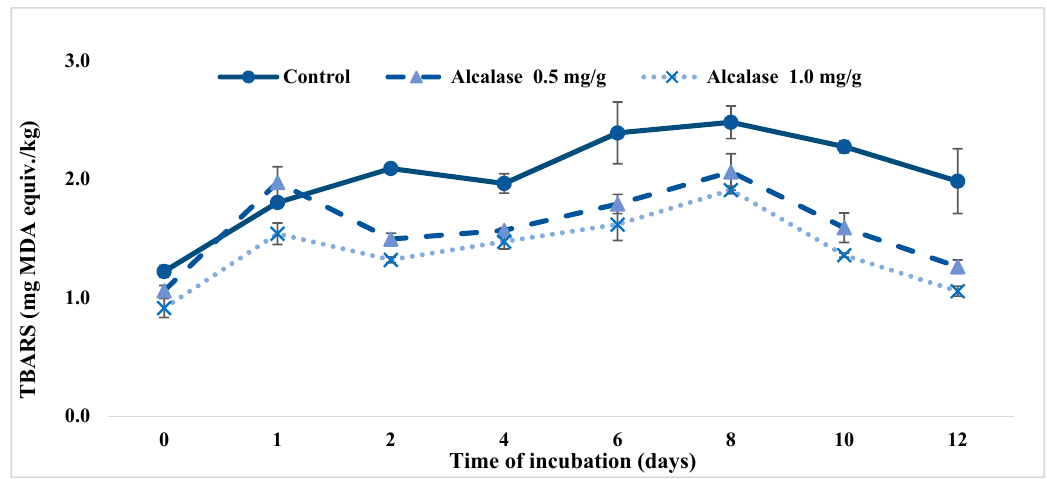
Figure 4 . Inhibition effects of kafirin Alcalase 5–10 kDa hydrolysates, measured as TBARS (mg Figure 4. Inhibition e ff ects of kafirin Alcalase 5–10 kDa hydrolysates, measured as malonaldehyde equivalent per kg of sample), prepared at enzyme-to-substrate ratio of 0.4 Au/g and hydrolyzed for 4 hr in a ground meat model system incorporated at 0.5 and 1 mg/g meat.